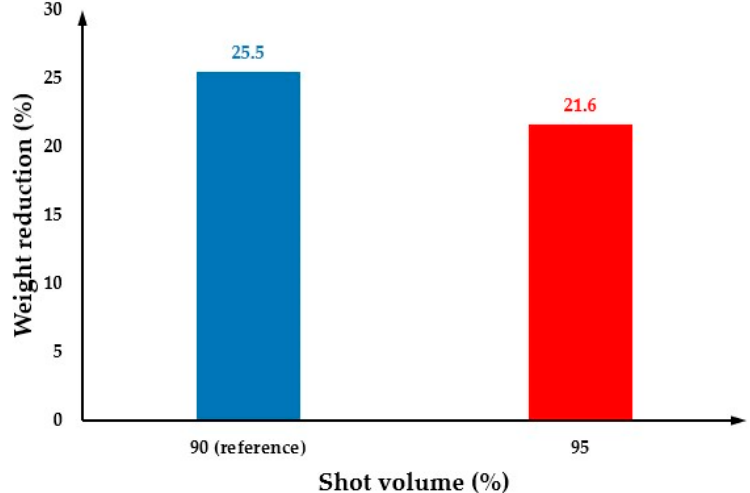
Figure 25. The weight reduction as a function of shot volume.